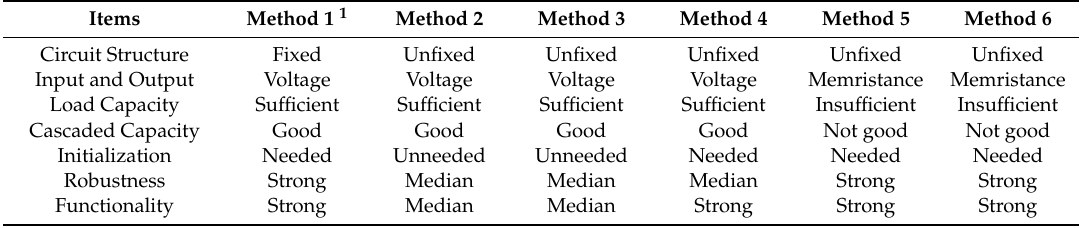
Table 4. Comparison of the proposed ternary logic circuit with other logic